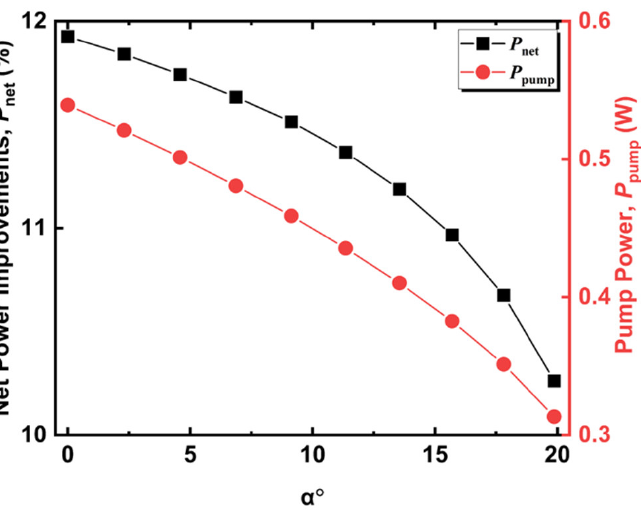
Figure 15. The percentage of the net power improvement and the required pump power as a function of the conical ring offset angle.